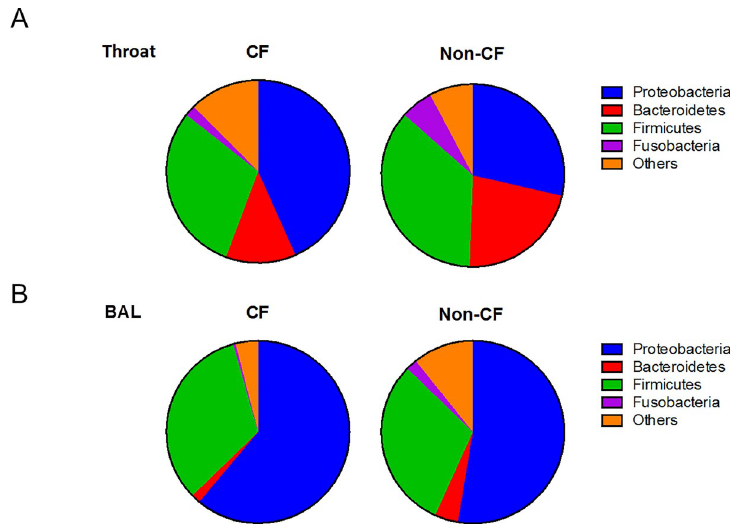
Fig 3. Relative proportions of microbial taxa of the aggregate microbiome at the phylum level. (A) microbial composition of the upper airways of CF children (left) and non-CF controls (right), (B) microbial composition of the lower airways of CF children (left) and non-CF controls (right). Each color denotes the proportion of taxa at the level of the phylum indicated.